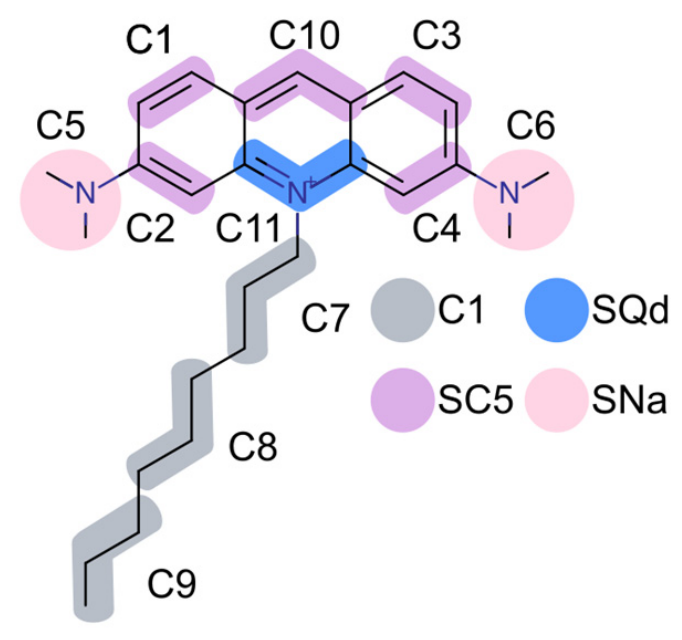
Figure 1. Structural formula of the NAO molecule with the AA to CG mapping according to the MARTINI force field. Bead types are differentiated by color. The bead names are labeled according to CG topology.